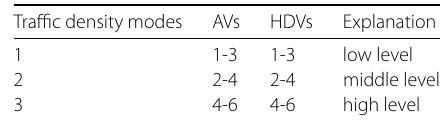
Table 1 Traffic density